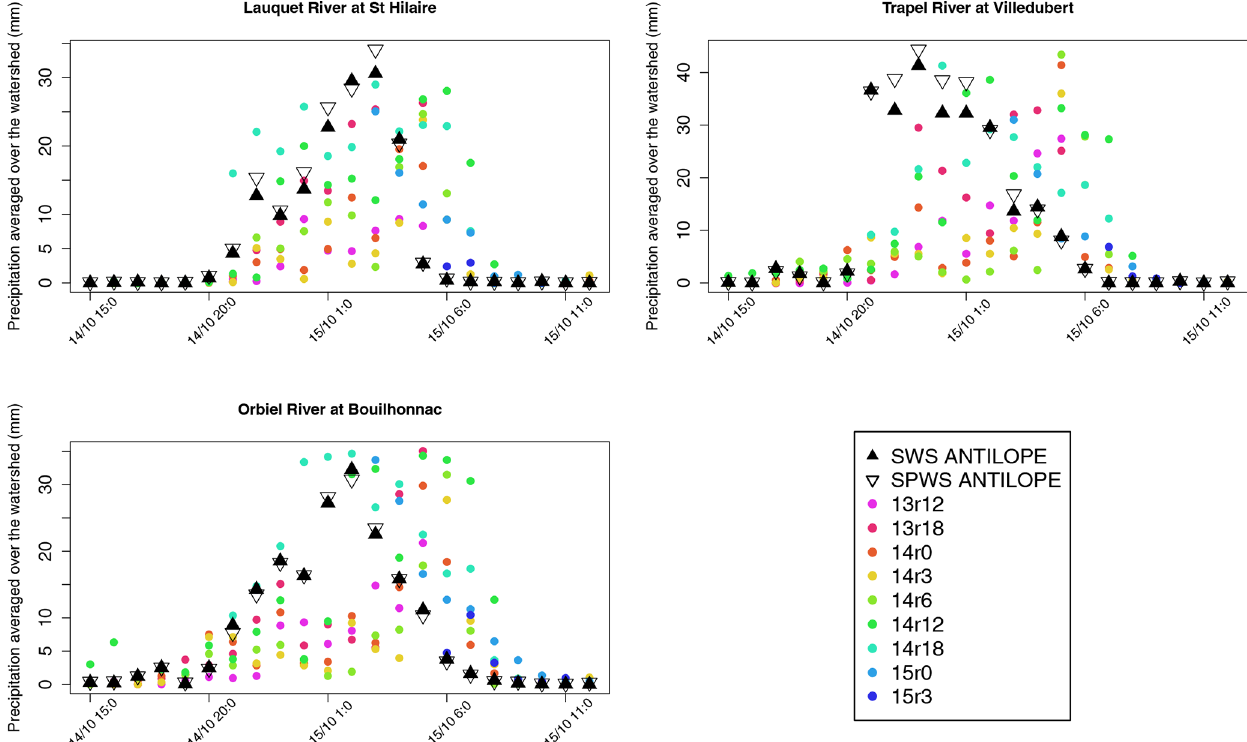
Figure 7. Time series of average hourly rainfall per watershed (in mm), observed by ANTILOPE and predicted by various runs of AROME- France. The nomenclature associated with the coloured dots is as follows: XrY corresponds to the run of AROME-France starting at Y UTC on X October